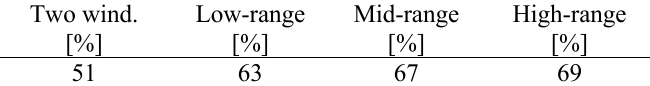
Table 5: Results for the maximum errors of Crols’